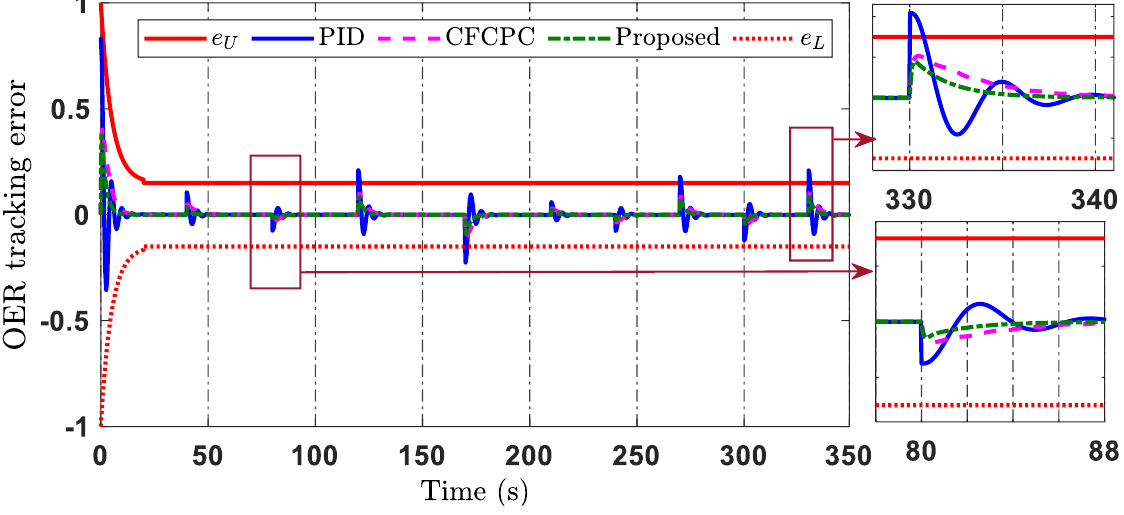
Figure 5. Performance tracking error of the proposed and comparative controllers in the simulation.